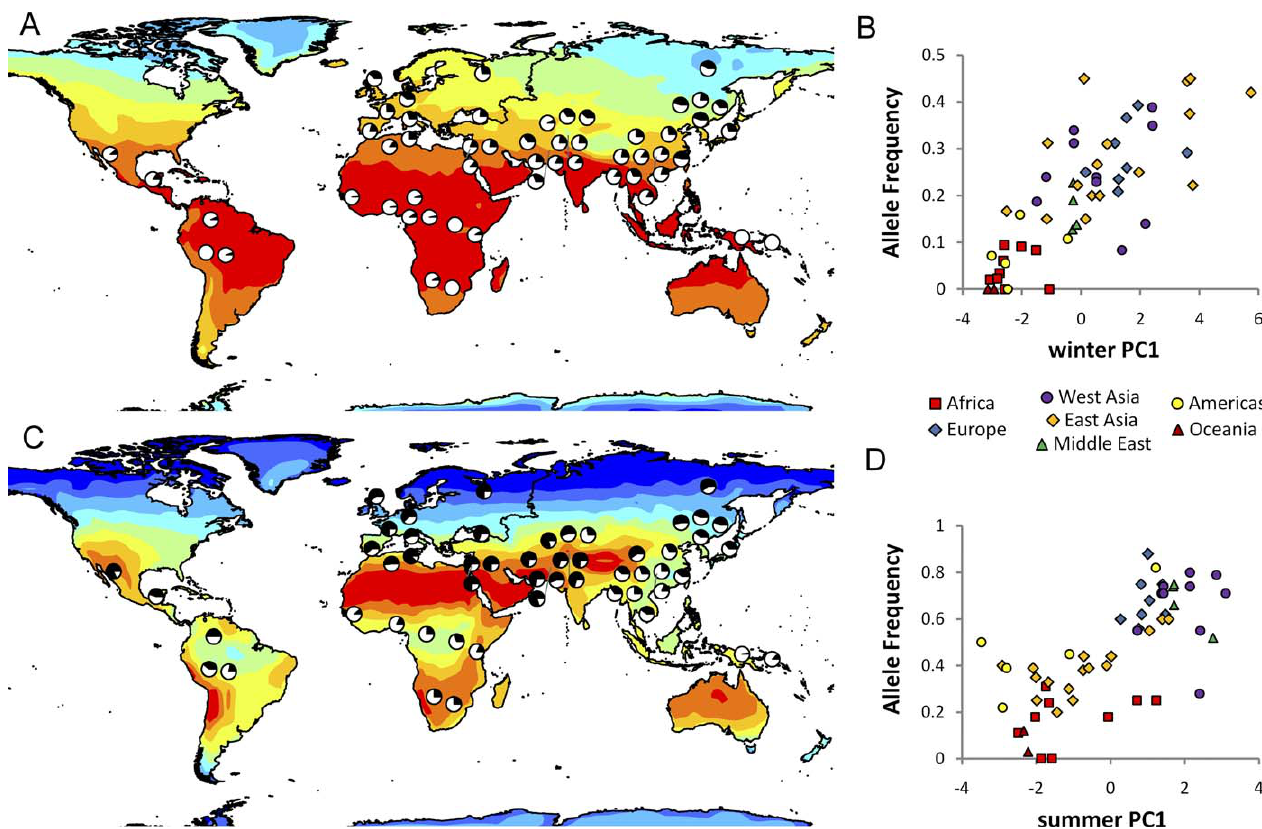
Figure 1. Allele Frequencies for rs12946049 in the RAPTOR Gene Are Mapped onto Winter Maximum Temperature (A) and Plotted against Winter PC1 (B) Allele frequencies for rs662 in the PON1 gene are mapped onto summer SWRF (C) and plotted against summer PC1 (D).